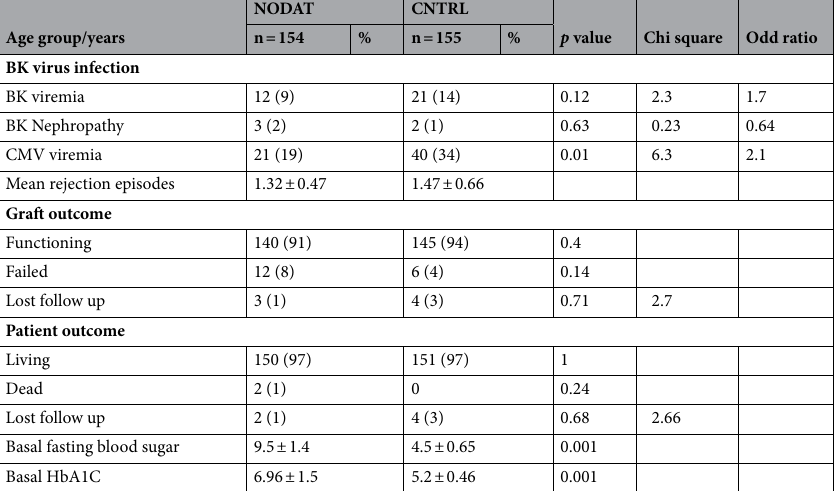
Table 3. Demographic data about NODAT and control. Demographic features of NODAT and control. Young participants, > 40 years old, individuals were significantly more frequent among controls, p ≤ 0.0001. The frequencies of NODAT in 40–60 and > 60 years old groups were higher than control, p < 0.0001 for both (pathophysiological feature of our NODAT). Induction of immunosuppressive drugs were significantly associated with NODAT than controls, p = 0.05 for all. Slow graft function showed to be more frequent in controls than NODAT, p = 0.03. Both basal fasting glucose and HbA1C were significantly higher in NODAT than control, p =